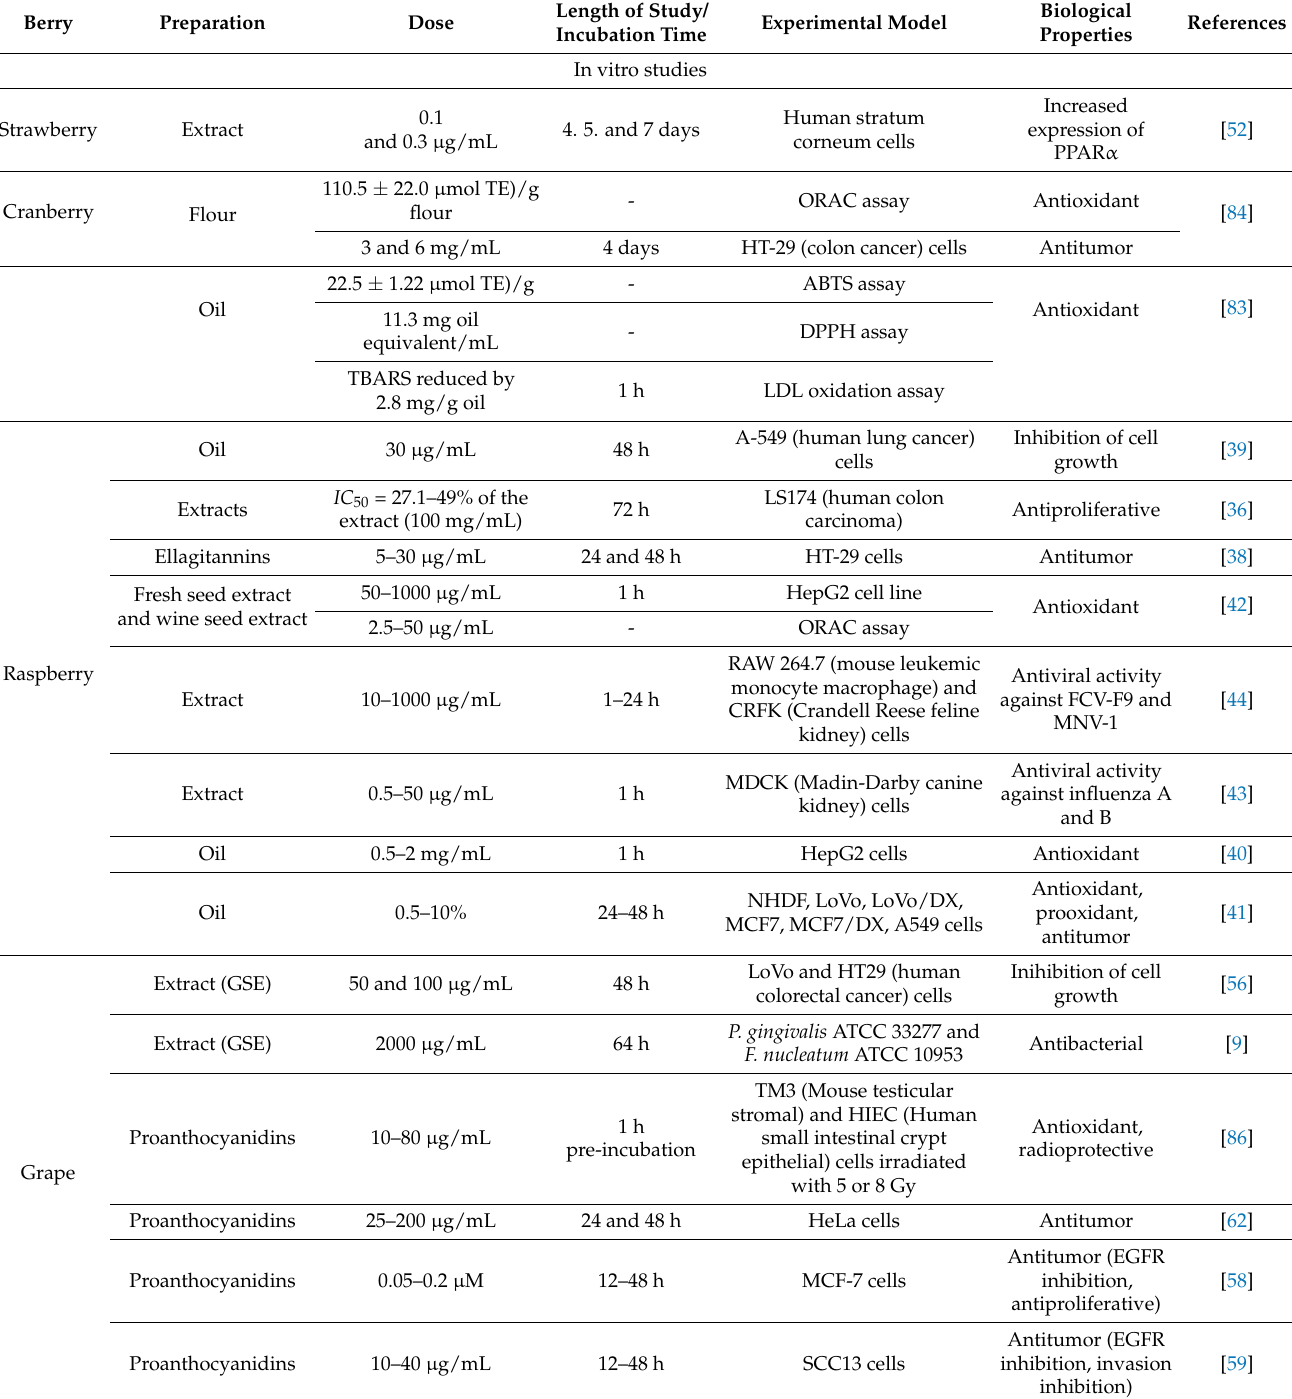
Table 3. Biological activity of berry seeds—in vitro and in vivo